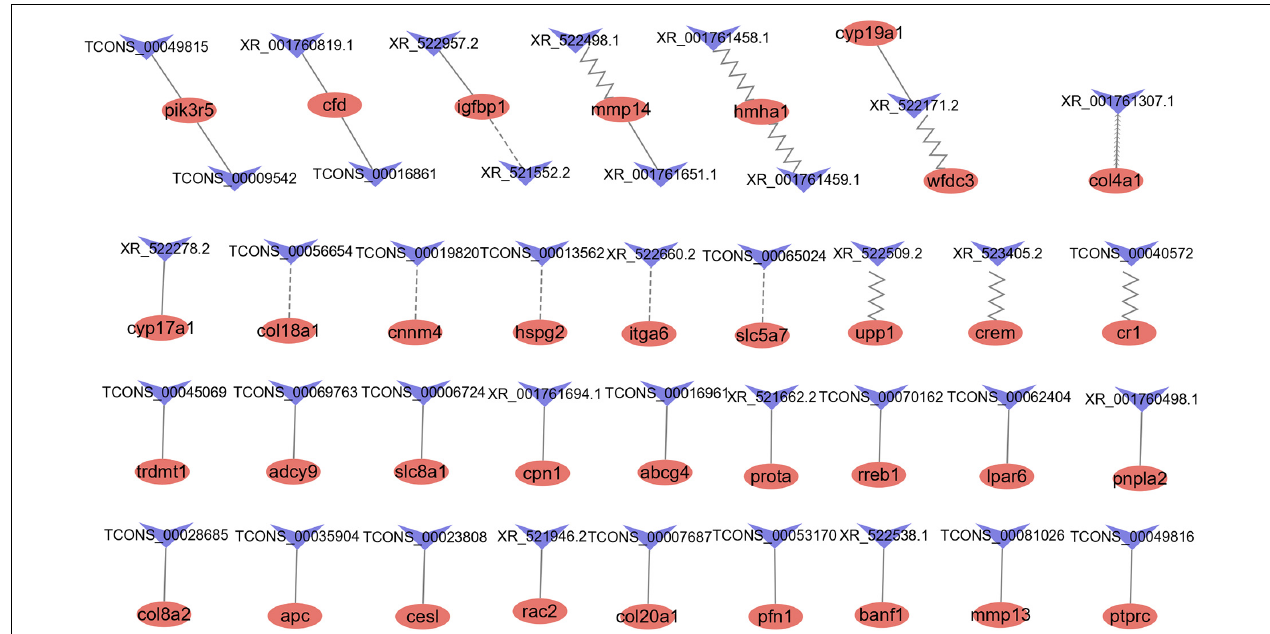
FIGURE 5 | LncRNAs and their potential antisense, cis -, and trans- target genes. Red ellipse represents mRNAs, blue “V” represents lncRNAs. The contiguous arrow, zigzag, dash, and solid line indicates the interaction between DE lncRNAs and its antisense, cis- , and trans- positive and negative target genes.